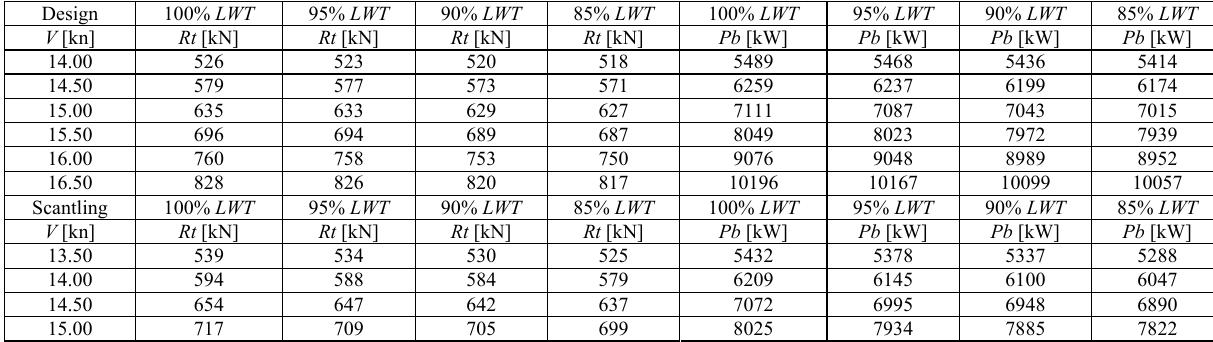
Table 12. Total resistance and brake power – design and scantling draught – bulk carrier 1 Design